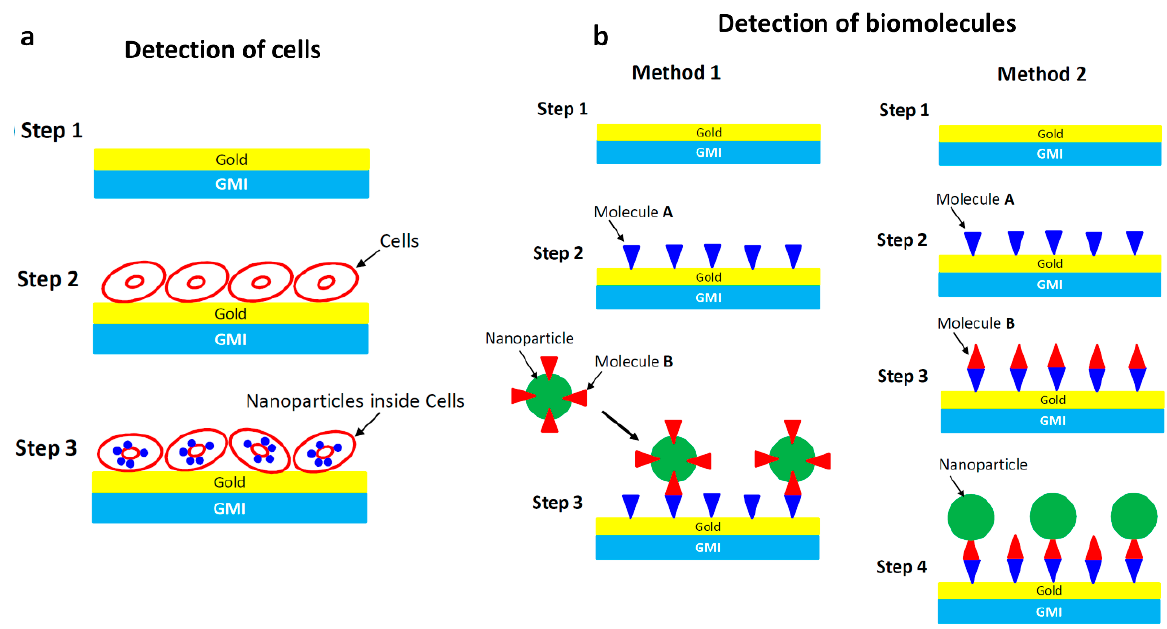
Figure 4. ( a ) Schematic illustration of the principle of detecting magnetic nanoparticles as magnetic labels inside cells; ( b ) schematic illustration of the principles of targeting and recognizing biomolecules. In Method 1, the magnetic nanoparticles are functionalized with target molecules (Molecule B), while in Method 2 the target molecules (Molecule B) are bound to the surface of the sensor.